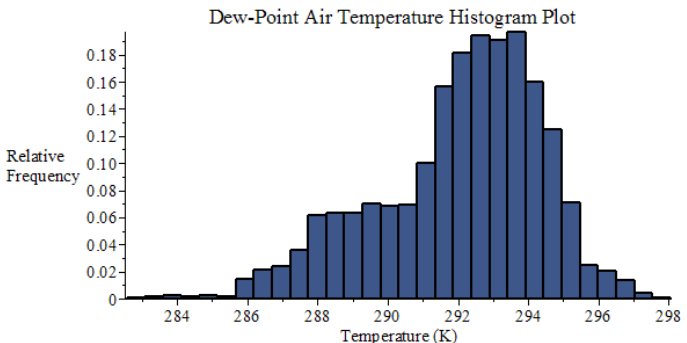
Figure B1. Histogram plot of dry-bulb air temperature data collected by SRNL from F-Area cooling towers (unsaturated conditions). Table B4. Statistics of the dry-bulb temperature (set to air inlet temperature) distribution [K].